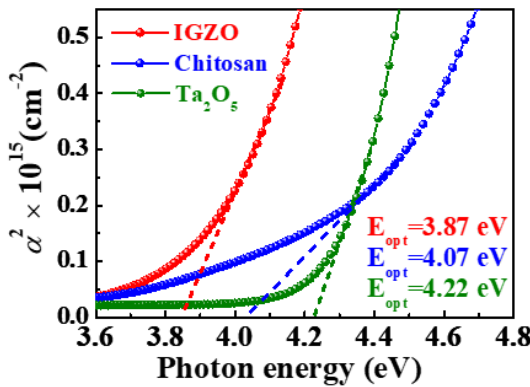
Figure 2. Optical band gap of the a −IGZO, chitosan, and Ta 2 O 5 layers constituting sol−gel composites−based synaptic transistors.